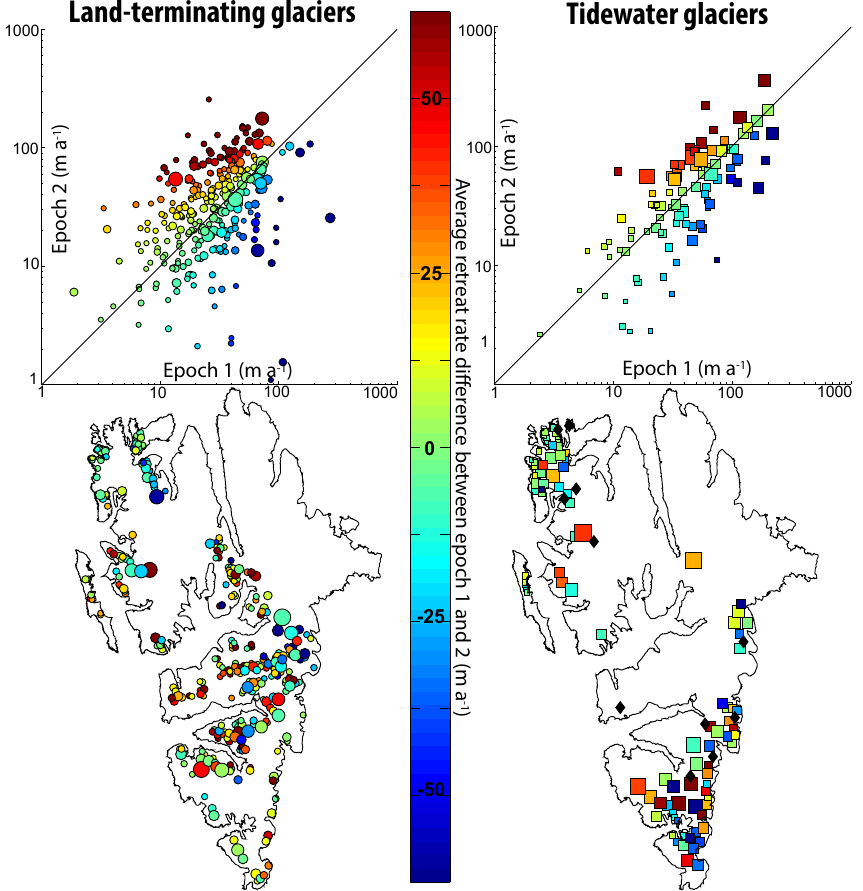
Fig. 10. Annual average length changes calculated using the “area/width” method for land-terminating (left) and tidewater (right) glaciers for Epoch 1 vs Epoch 2. Colors represent the difference in average retreat rates between the epochs. Black diamonds are glaciers that have advanced in either Epoch 1 or 2. Symbols in the maps (bottom) are identical to those in the scatter-plots (top). In the scatter-plots, points below the 1 : 1 line are glaciers that have experienced smaller retreat rates in Epoch 2 (blue) while points above the line are glaciers that have experienced greater retreat in Epoch 2 (red). Note the log scale of the scatter plot and linear color scale in the difference of average retreat rates. The size of the symbol is a log scale of the glacier size.